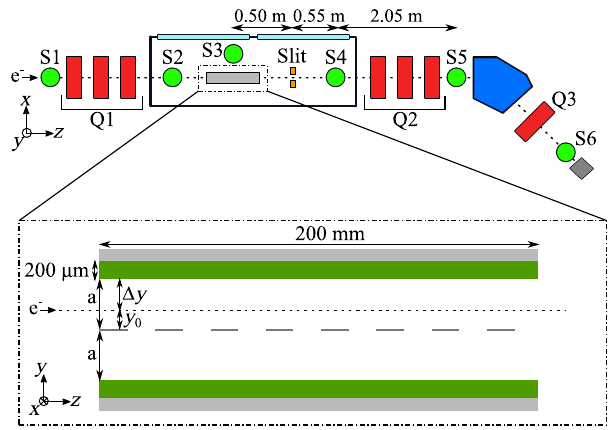
FIG. 1. Schematic of the experiment performed at CLARA BA1, with an inset showing the DWA structure and coordinate system used for defining structure gaps and beam